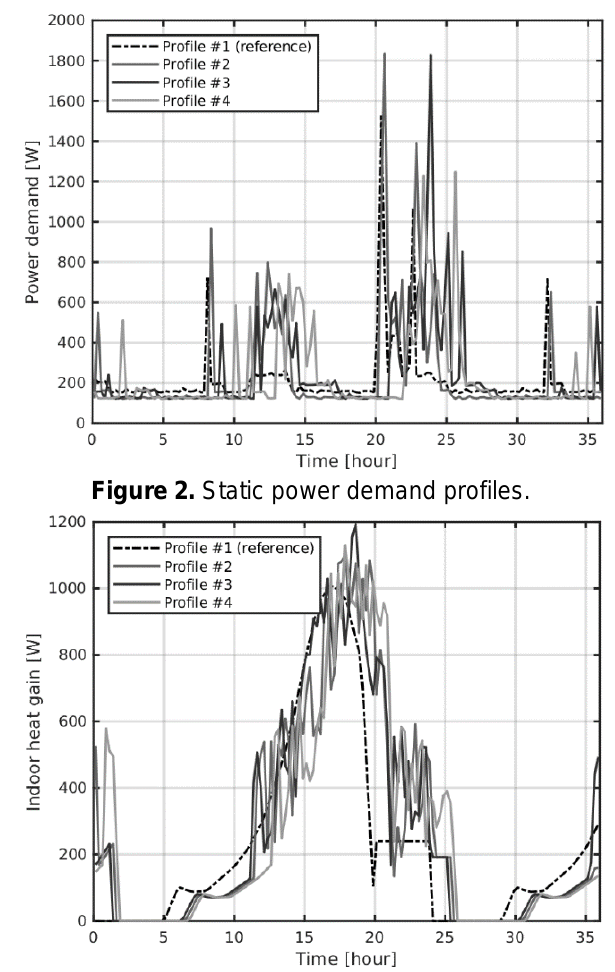
Figure 3. Indoor heat gain profiles.